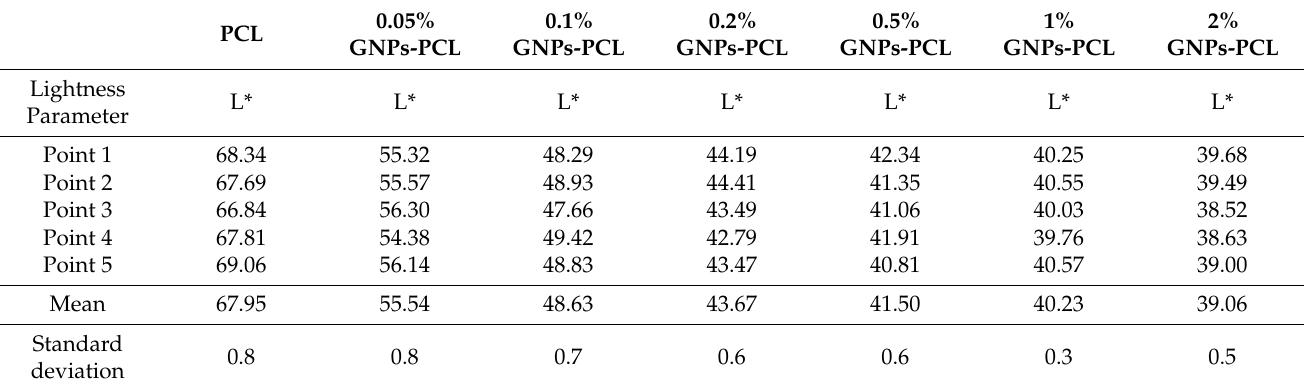
Table 1. CieLab lightness coordinates measured in five different points of each